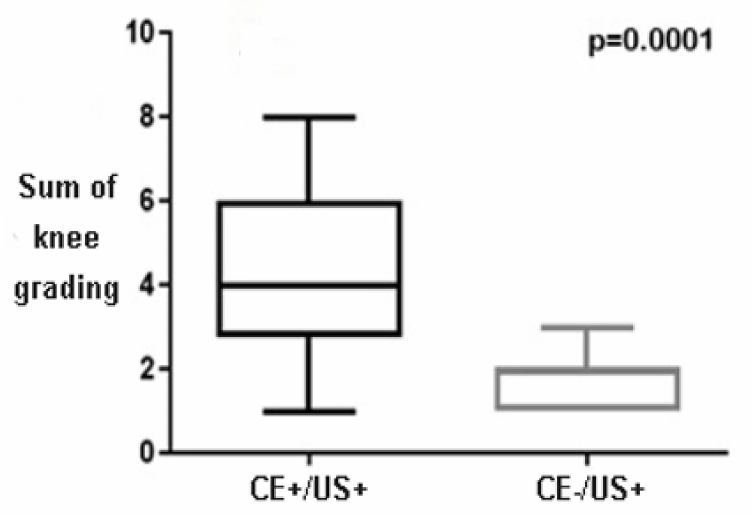
Figure 1. The comparison between the sum of grading (synovial hyperplasia + synovial effusion + PD) in the knee. US, ultrasound; CE, clinical